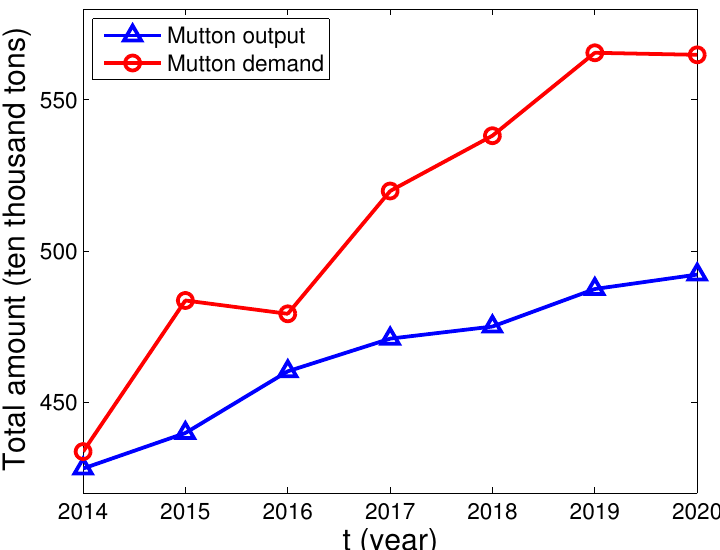
Figure 1. Supply and demand of mutton in China. The data of mutton output were obtained from China Statistical Yearbook 2021. The data of mutton demand are the sums of domestic output and net import which come from the web of UN Comtrade Database (https://comtrade.un.org/ (accessed on 5 March